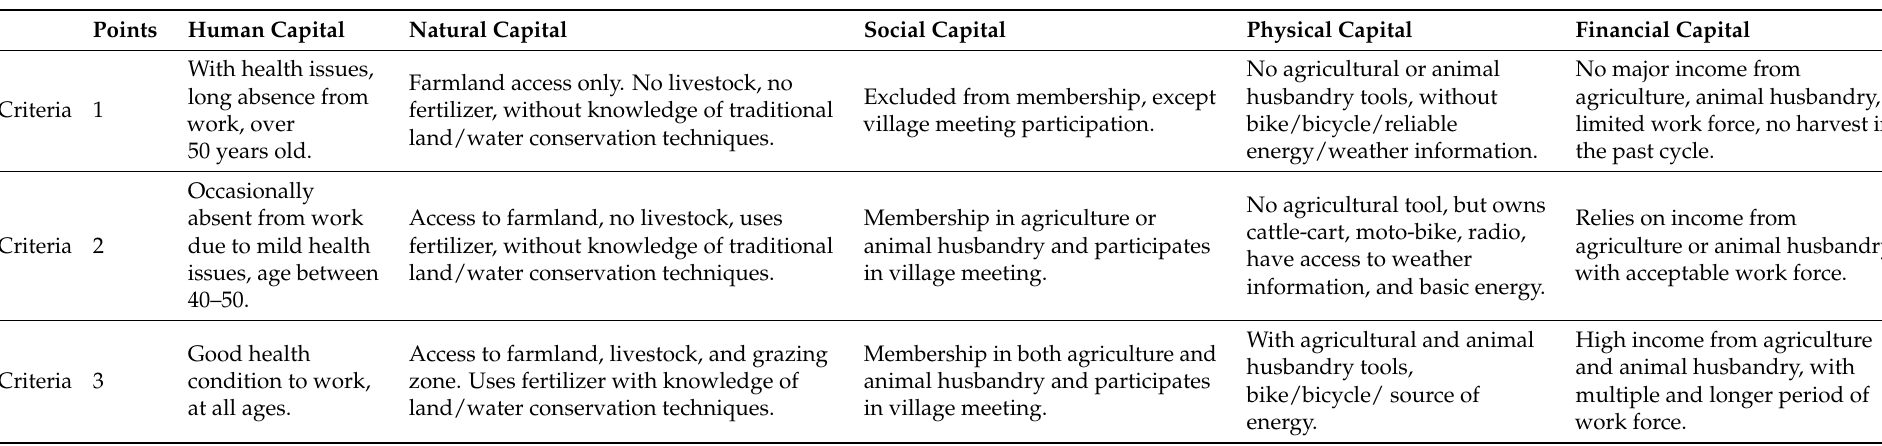
Table 2. Criteria for evaluating different types of capital based on framework by the DFID